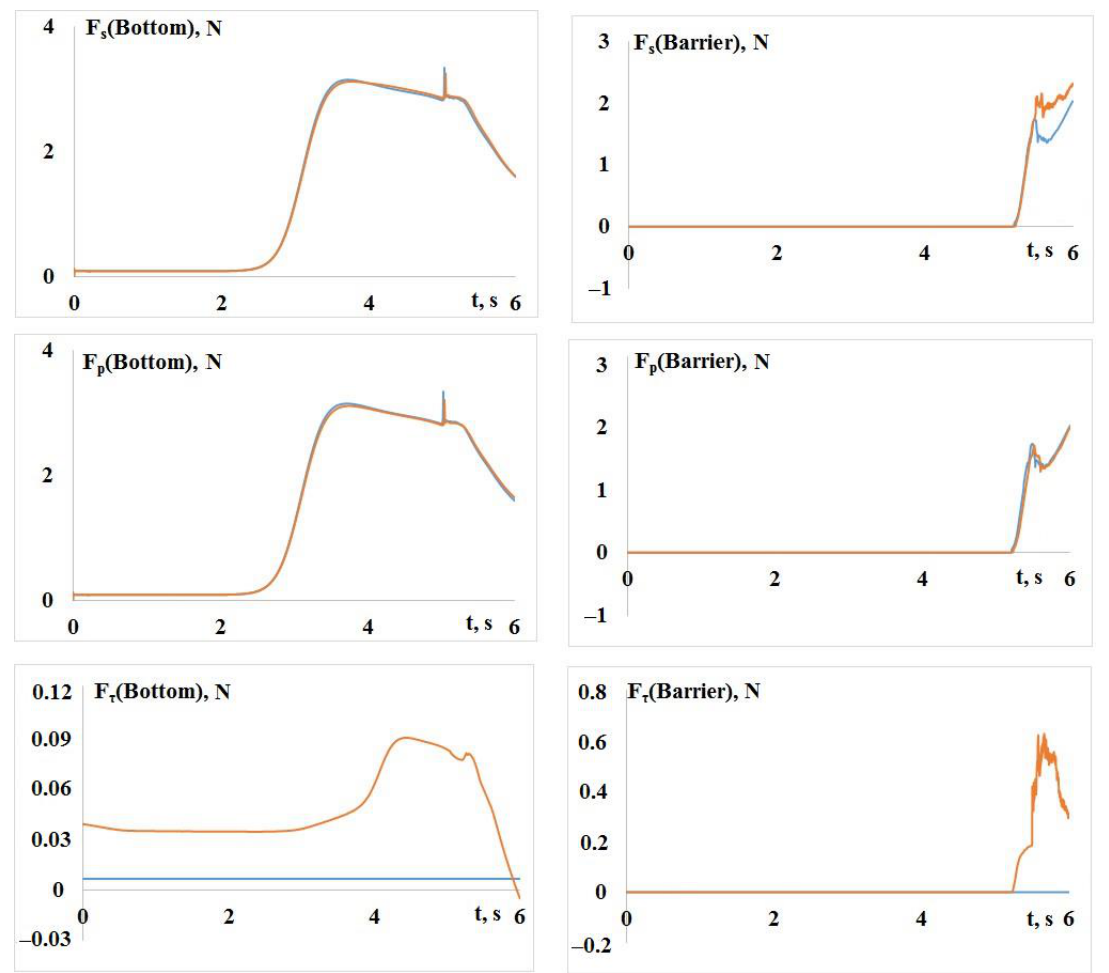
Figure 7. Comparison of the forces acting on the channel bottom in the slope and barrier zones for setup 2 ( —without TM, —with TM).